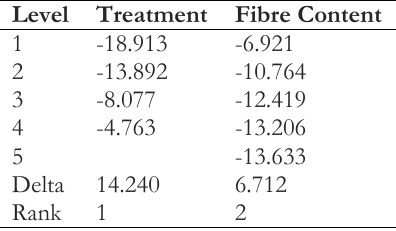
Table 6. Response table for signal-to-noise ratios of percentage of water absorption - smaller is